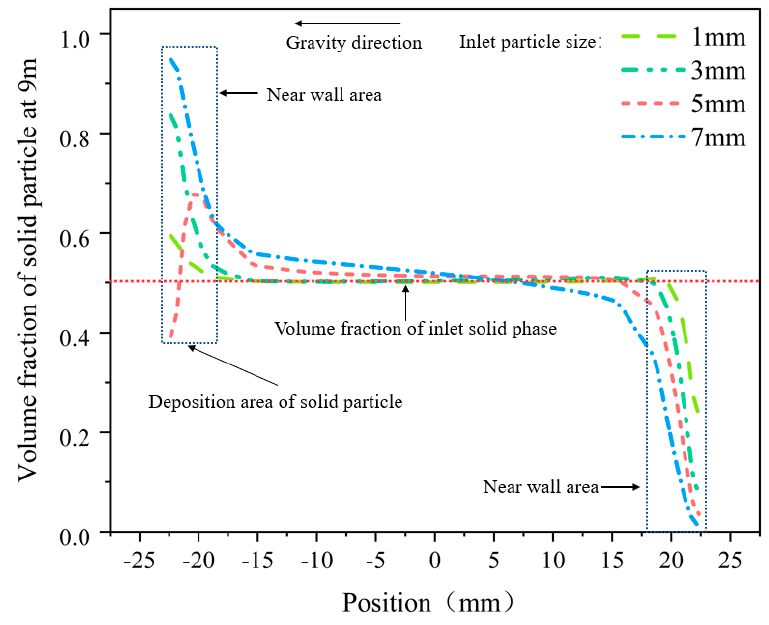
ff ect of solid particle size change on the migration Figure 9. Effect of solid particle size change on the migration process. Figure 9. E